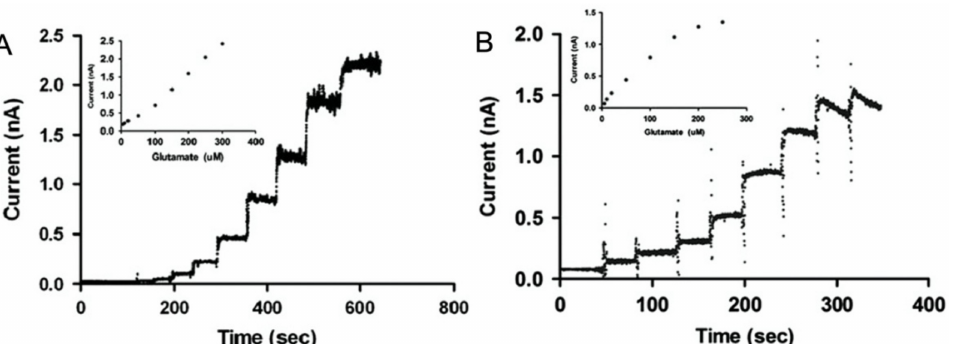
Figure 13. ( A ) Glutamate sensing using three electrodes. ( B ) Glutamate sensing using two electrodes. Reprinted with permission from reference [66]. Copyright 2012 Elsevier